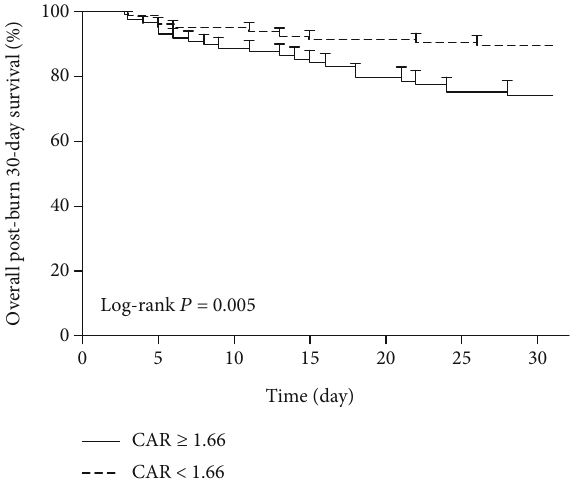
Figure 5: CAR at admission associated with postburn 30-day mortality by the Kaplan – Meier survival analysis. CAR: C-reactive protein-to-albumin